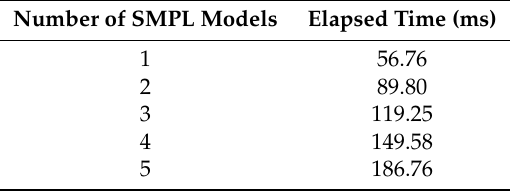
Table 3. Time consumed by an iteration with different number of SMPL models. The number of detection rays is 512 ×